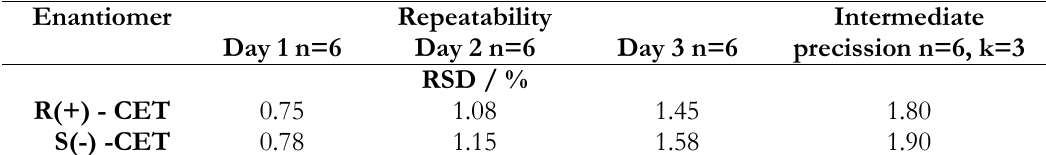
Table II Intra and inter-day repeatability of carvedilol to SI peak-area ratio (n-number of experiments; k-day of experiment; RSD / % -relative standard deviation; sample concentration, IS concentration - 10µg/mL -1